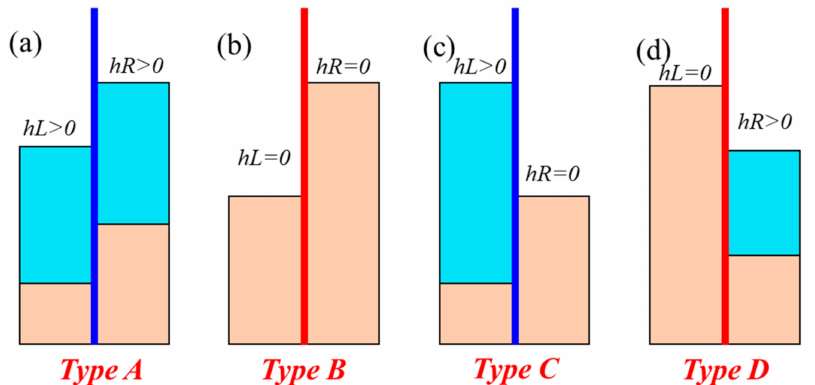
Figure 2. Classification of interface property. ( a ) Type A: wet cells at the left and right side, hL > 0, hR > 0, hL and hR are flow depth in the left and right side of intercell respectively; ( b ) Type B: dry cells at the left and right side of the intercell face; ( c ) Type C: wet and dry cells are connected through the intercell face, the free surface elevation of the wet cell is higher than the dry cell; ( d ) Type D: wet and dry cells are connected between the intercell face, and the free surface elevation of the wet cell is lower than the dry cell.